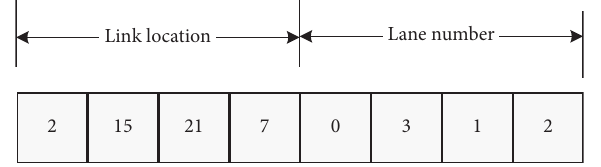
Figure 5: An illustration of encoding for the upper level